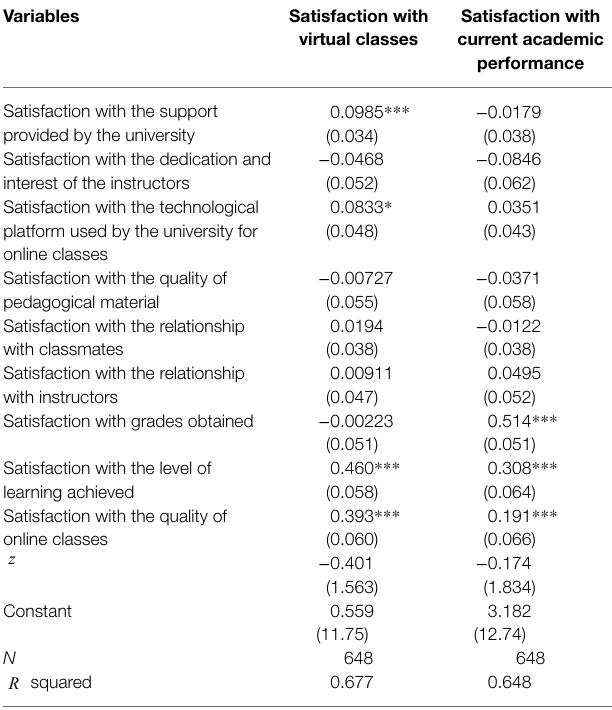
TABLE 3 | Two-layer method, second layer: subjective wellbeing of students, controlling for z.